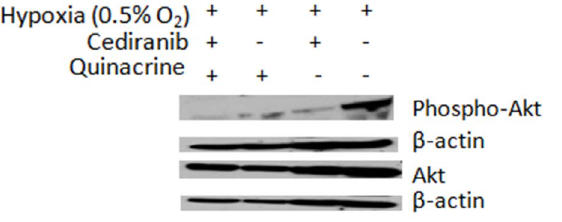
Fig. 4. Cediranib and quinacrine inhibit Akt activation. Western blot analysis of basal Akt and phospho-Akt levels in 4C8 cultures grown under hypoxic (0.5% O 2 ) conditions for 24 hrs while untreated or exposed to cediranib (2.5 m M), quinacrine (2.5 m M), or combined